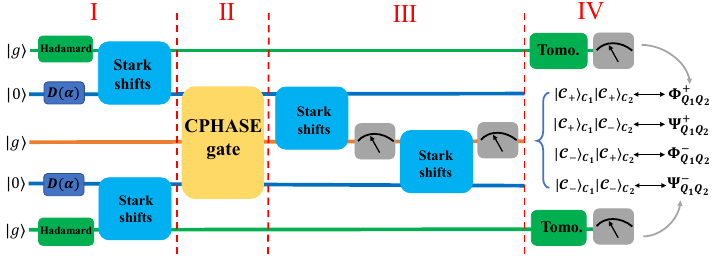
Figure 2. Simulated experimental sequences. The procedure consists of four parts: ( I ) Generation of entangled states for Q 1 , C 1 and Q 2 , C 2 through the Stark shifts induced by dispersive qubit–cavity interaction; ( II ) application of a CPHASE gate operation on the two cavities to transform the entangled coherent state elements into the direct product of even or odd cat elements; ( III ) distinguishing the four combinations of cat states of the two cavities to collapse the two qubits into a specific entangled state; and ( IV ) reconstruction of the density matrices for Q 1 and Q 2 , which can be achieved by standard process of quantum state tomography, as reported in the previously demonstrated experiments